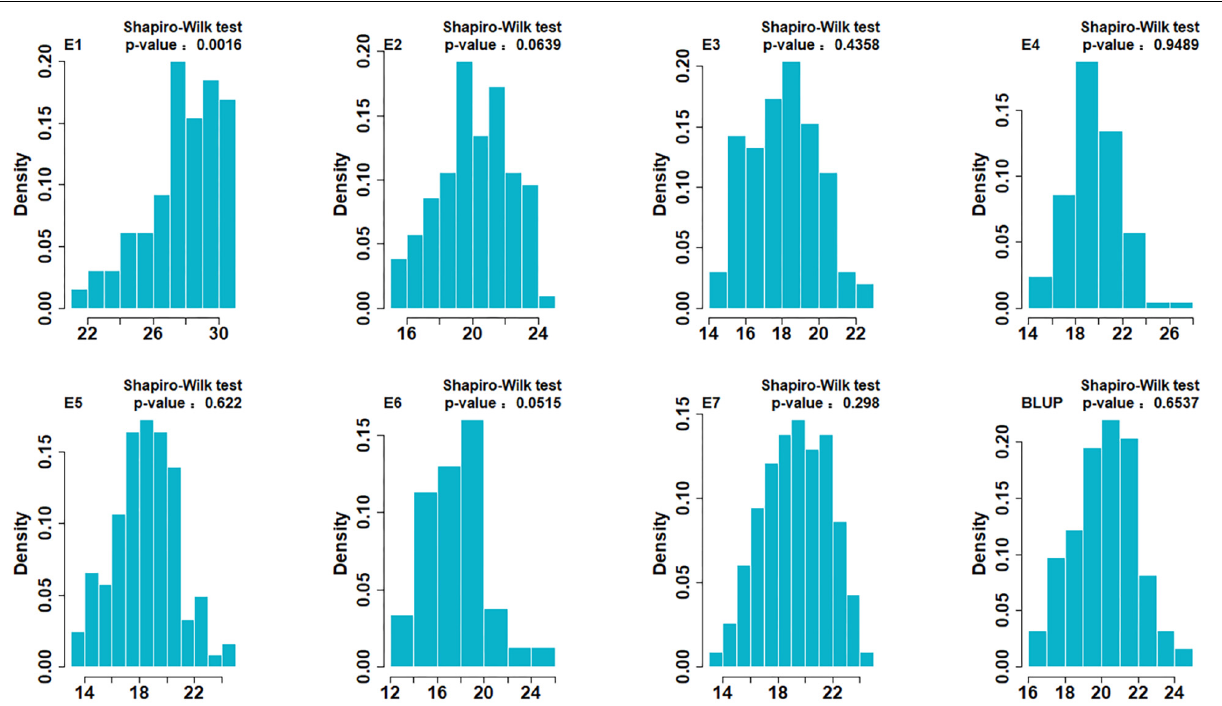
segregation, suggesting that both parents have increasing alleles for SSV. The broad-sense heritability values in all environments were greater than 0.8, indicating that SSV the Shapiro-Wilk test displayed that SSV exhibited normal distribution under six environments and BLUP value, indicating SSV was determined by many genes ( Figure 1 ). Pearson’s correlation coefficient analysis was carried out between farinograph parameters and SSVs of 30 DH lines planted in E5 which indicated a significant positive correlation between